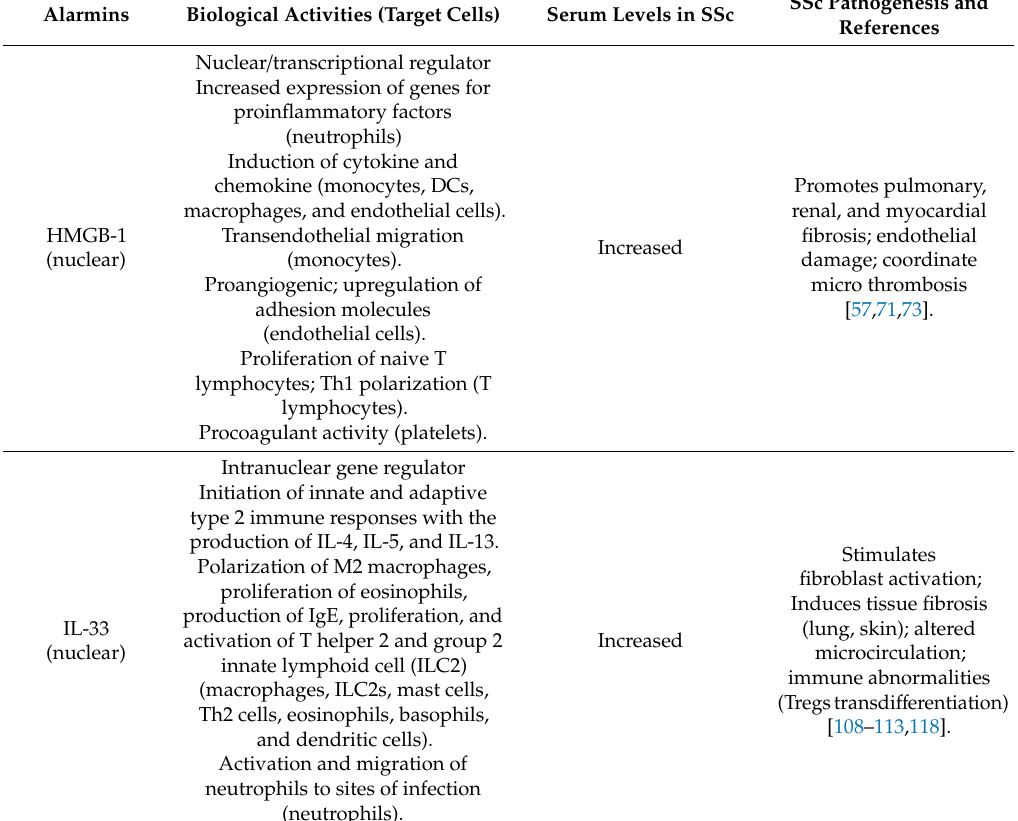
Table 1. Alarmins involved in SSc